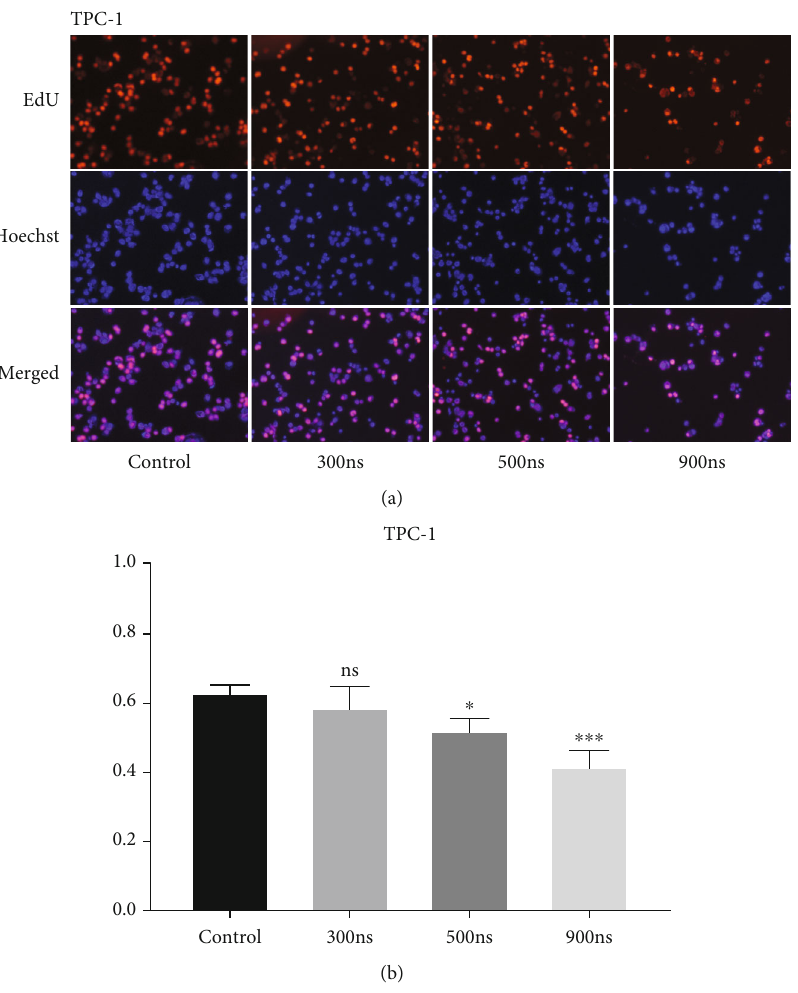
Figure 4: NsPEFs inhibited the proliferation of TPC-1 cells. (a) After nsPEFs treatment with di ff erent parameters and staining, the cells were observed under an inverted microscope. (b) NsPEFs with longer pulse duration signi fi cantly inhibited cell proliferation. ∗ p < 0 : 05 ; ∗∗ p < 0 : 01 ; ∗∗∗ p < 0 : 001